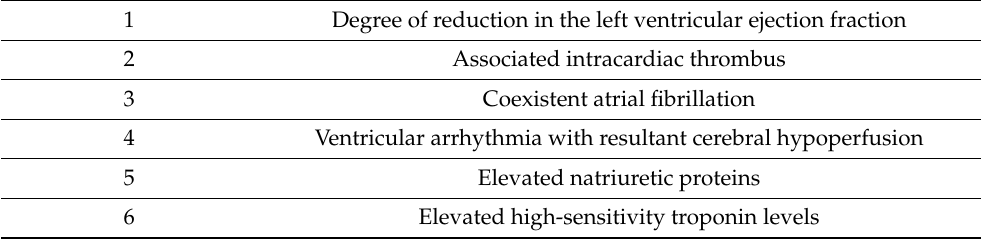
Table 5. Potential Factors which may Enhance Cardioembolic Stroke in Heart